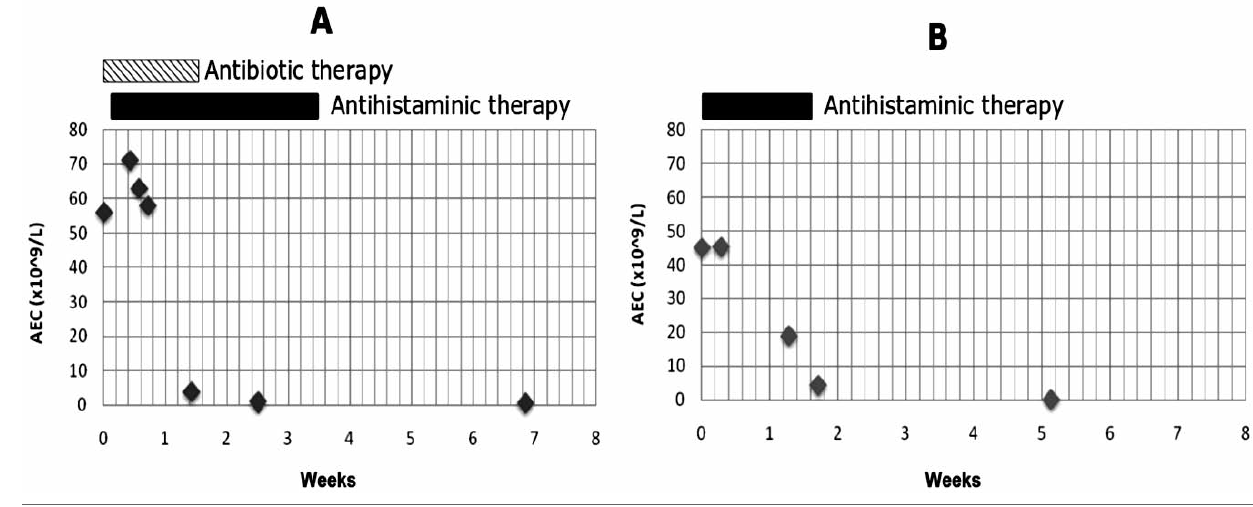
Figure 1. Absolute eosinophil count trend and concomitant therapy during the first (A) and the second hospitalization